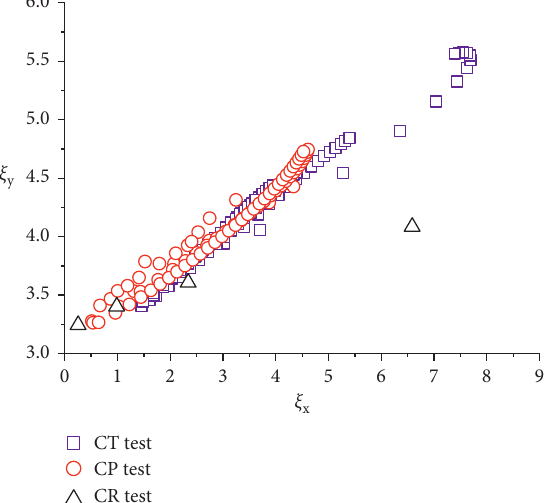
Figure 10: CIR test of limestone rockfill materials [27] (d σ 1/ d σ 3 � 8).